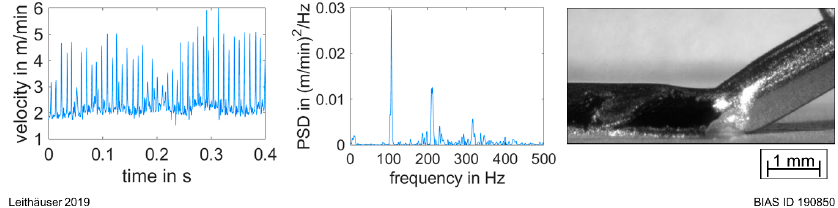
Figure 5. ( Left ) Wire velocity over time, when the wire hits the sheet and the retained force is released periodically. ( Middle ) Power spectral density (PSD) of the time signal. ( Right ) Snapshot of the high-speed recording during these events.